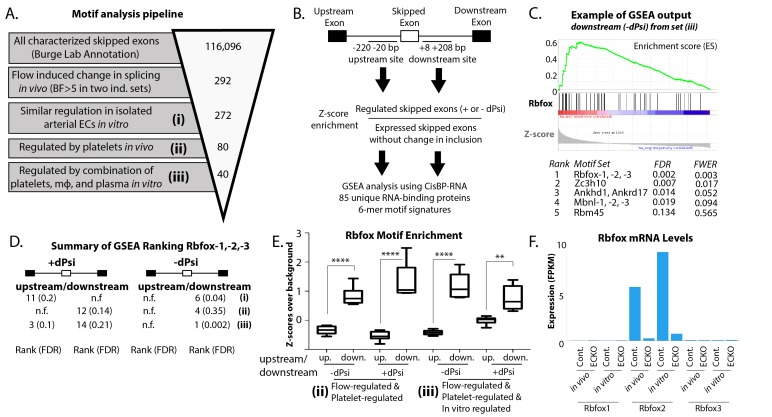
Enrichment of an Rbfox motif in the platelet/macrophage-regulated subset identified in vivo and in vitro.(A) Motif analysis pipeline, showing the number of potentially regulated skipped-exon events, and those passing each filter. (B) Events were separated into those with increased or decreased inclusion, and then the sequences of the upstream and downstream 200 bp flanking regions were isolated, resulting in four regions of analysis. 6-mer motifs in each region were assessed for enrichment relative to exons expressed in six matched background sets of skipped exons not regulated by flow. GSEA was used to identify splicing factor ‘fingerprints’ among these enriched motifs, using the motif-binding preference defined by the CisBP-RNA database (Ray et al.). (C) Example of enrichment of Rbfox binding motif in GSEA analysis of 85-unique RNA-binding protein signatures against flanking intron sequences of flow-regulated exons. Plot shows enrichment of Rbfox family motifs among the motifs most enriched above background in the downstream flanking region of exons regulated in vivo and in vitro (set iii). (D) Enrichment of the Rbfox2 motif in each of the sets of biologically defined regulated exons (i-iii) within the upstream and downstream flanking regions of exons with either increased or decreased inclusion. (E) Plot showing the average z-score enrichment of the top 5 Rbfox in vitro defined motifs in the flanking regions of the in vivo regulated exon set (80 SE) and the in vitro regulated subset (40 SE), relative to the six matched background sets (N = 6 per bar). (F) Transcript levels of Rbfox family of proteins in the carotid artery in vivo and in isolated aortic endothelial cells in vitro, with or without the deletion of Rbfox2 by Cdh5(PAC)-CreER (EC-KO). FPKM = Fragments Per Kilobase of transcript per Million mapped reads. FDR; false-discovery rate; n.f.; not found. p<0.0001 (****), p<0.01 (**).10.7554/eLife.29494.021Figure 3—source data 1.Contains the pared down list of flow-regulated events and their annotations (e.g. platelet regulated).See GEO file GSE101826 for annotation of samples.10.7554/eLife.29494.022Figure 3—source data 2.Contains the list of intervals used for motif enrichment around the indicated regulated exons for the indicated sets (e.g. increased inclusion in flow regulated set).10.7554/eLife.29494.023Figure 3—source data 3.Contains a list of expressions across samples for all known RNA binding proteins.10.7554/eLife.29494.024Figure 3—source data 4.Contains the list of all motifs, their enrichment adjacent to regulated exons, their conservation score, and the z-score enrichment of the motif from the CisBP-RNA database.